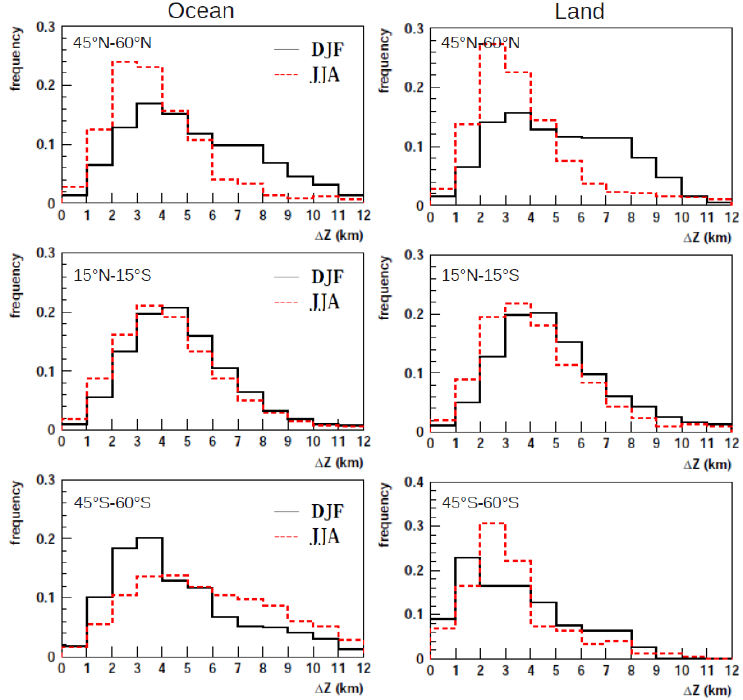
Fig. 12. Normalized frequency distributions of vertical extent of ST-HICs for three latitude bands. Boreal winter and boreal summer are represented with black and red lines, respectively. Statistics is over the period